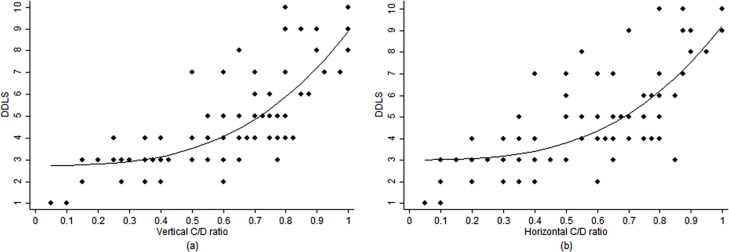
Scatterplot showing the association between DDLS and C/D ratio.(a) DDLS and vertical C/D ratio, (b) DDLS and horizontal C/D ratio. Abbreviations: DDLS, Disc Damage Likelihood Scale; C/D, cup-to-disc.